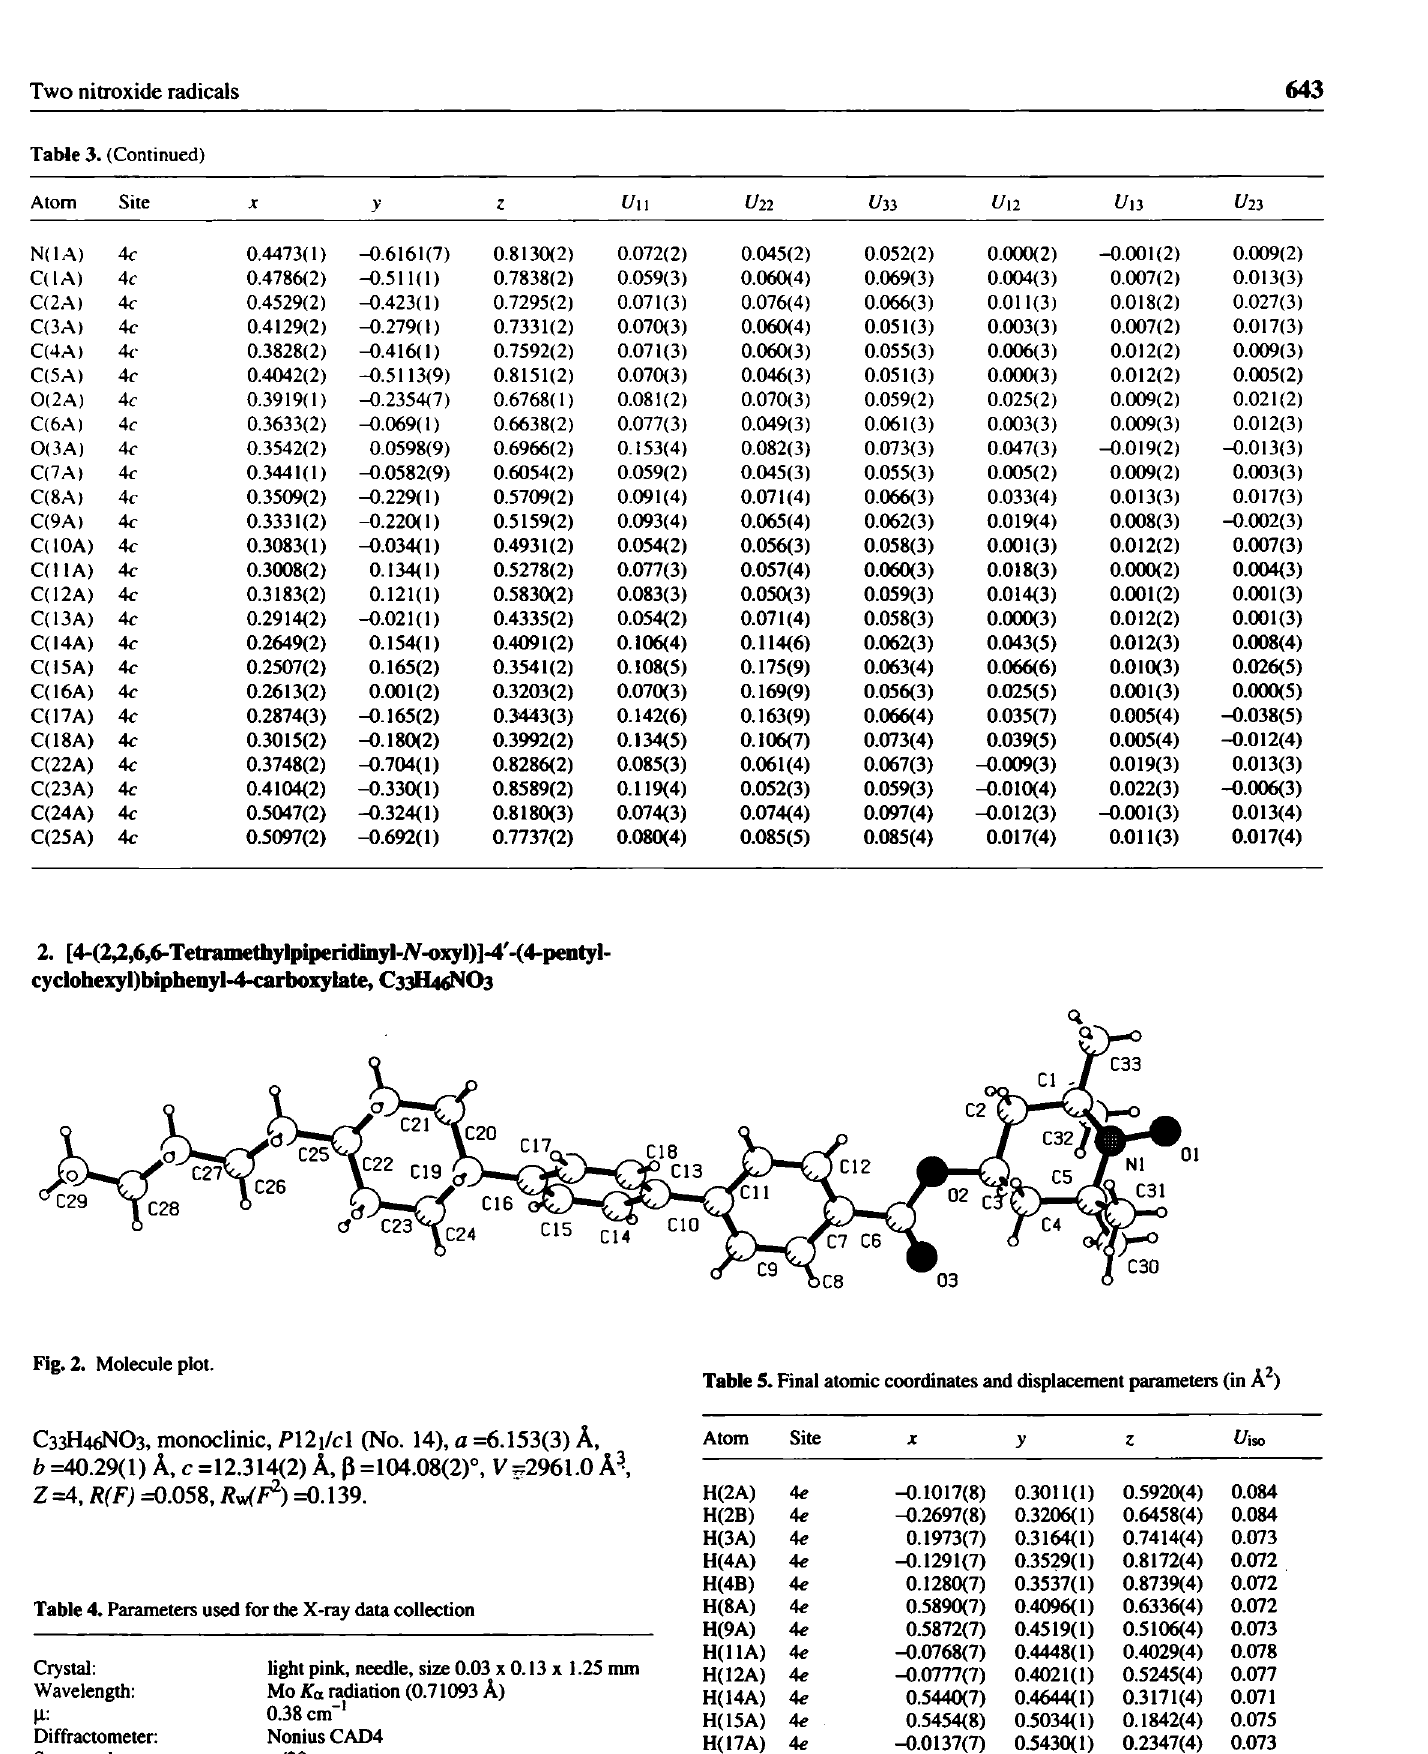
Table 4. Parameters used for the X-ray data collection